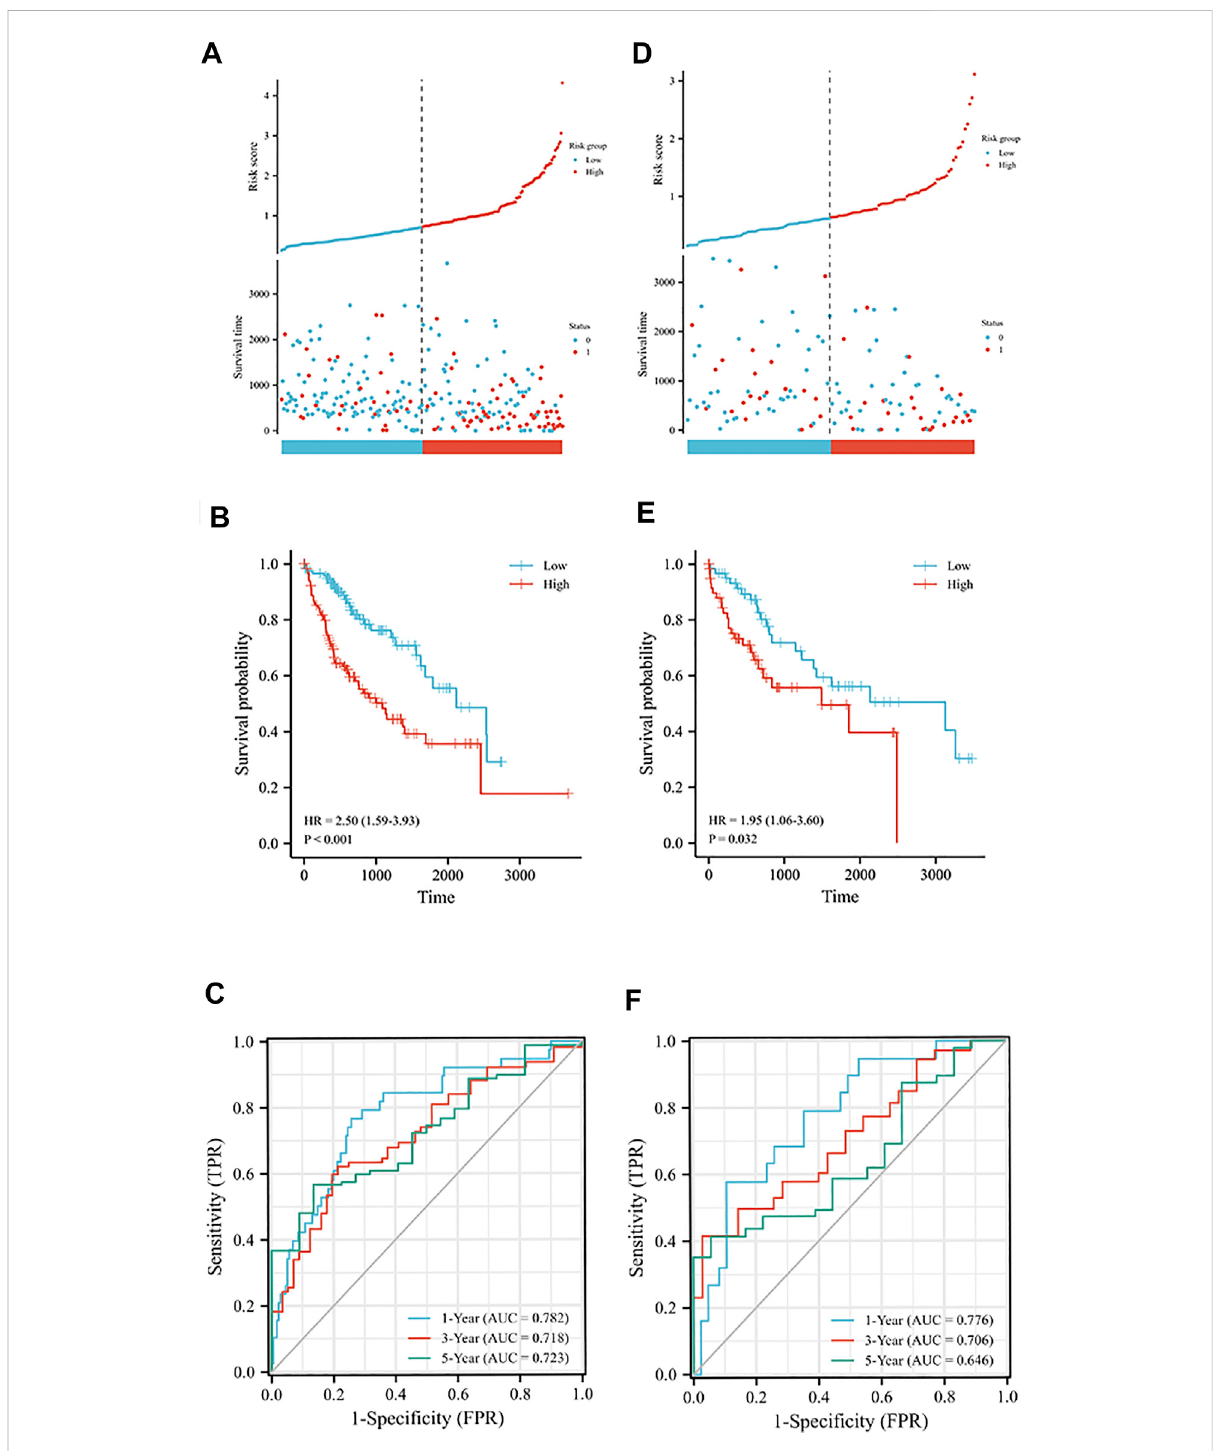
FIGURE 3 Prognosticanalysisofexosome-relatedlncRNAsignatureinthetrainingandvalidationcohorts. (A) Distributionofriskscoresandoverallsurvival statusinthetrainingcohort. (B) Kaplan-Meiercurvesfortheoverallsurvivalofpatientsinthehigh-andlow-riskgroupsinthetrainingcohort. (C) The time-dependentROCcurvessupportingprognosticaccuracyoftheriskscoreinthetrainingcohort. (D) Distributionofriskscoresandoverallsurvival status in the validation cohort. (E) Kaplan-Meier curves for the overall survival of patients in the high- and low-risk groups in the validation cohort. (F) The time-dependent ROC curves supporting prognostic accuracy of the risk score in the validation